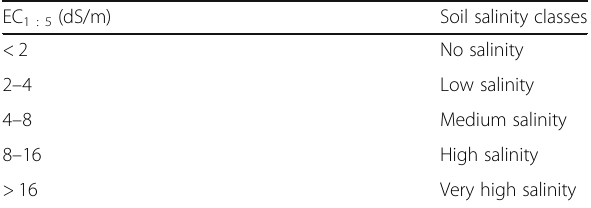
Table 1 Classification of soil salinity based on electrical conductivity values (http://vro.agriculture.vic.gov.au/dpi/vro/